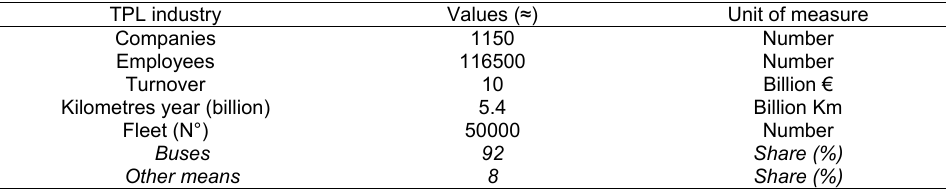
Table 3: key data of the LPT